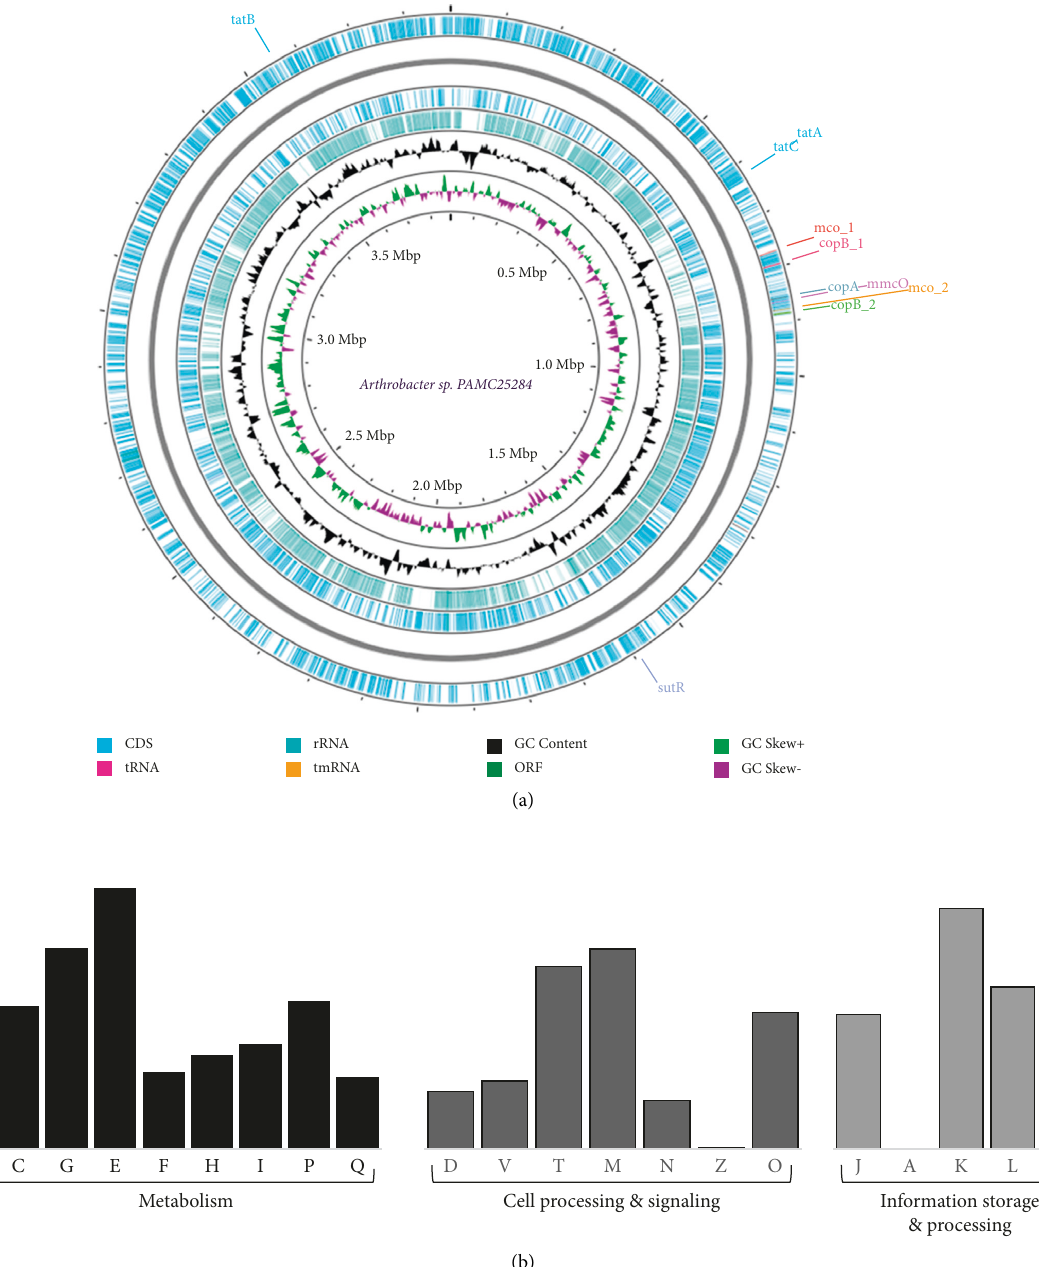
Figure 1: (a) Circular representation of genome and features of the Arthrobacter sp. PAMC25284. The contents of the featured rings (starting with the outermost ring to the center) are as follows: Ring 1, CDS (including tRNA and rRNA0 and Pokka annotation with genes that are involved in copper homeostasis; Ring 2, combined ORFs in forward and reverse strands; Ring 3, plot of GC content; Ring 4, GC skew plot, values above average are depicted in green, and below average in purple; and Ring 5, sequence ruler. (b) COG functional categories for forward coding sequences. Metabolism: C, energy production and conversion; G, carbohydrate transport and metabolism; E, amino acid transport and metabolism; F, nucleotide transport and metabolism; H, coenzyme transport and metabolism; I, lipid transport and metabolism; P, inorganic ion transport and metabolism; Q, secondary metabolites biosynthesis, transport, and catabolism. Cell processing and signaling: D, cell cycle control, cell division, and chromosome partitioning; V, defense mechanisms; T, signal transduction mechanisms; M, cell wall/membrane/envelope biogenesis; N, cell motility; Z, mobilome, prophages, and transposons; O, posttranslational modification, protein turnover, and chaperones. Information storage and processing: J, translation, ribosomal structure, and biogenesis; A, RNA processing and modification; K, transcription; L, replication, recombination, and repair; B, chromatin structure and